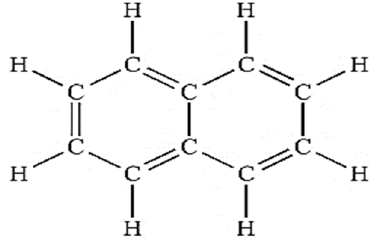
Figure 13. Chemical structure of metabolite (naphthalene).